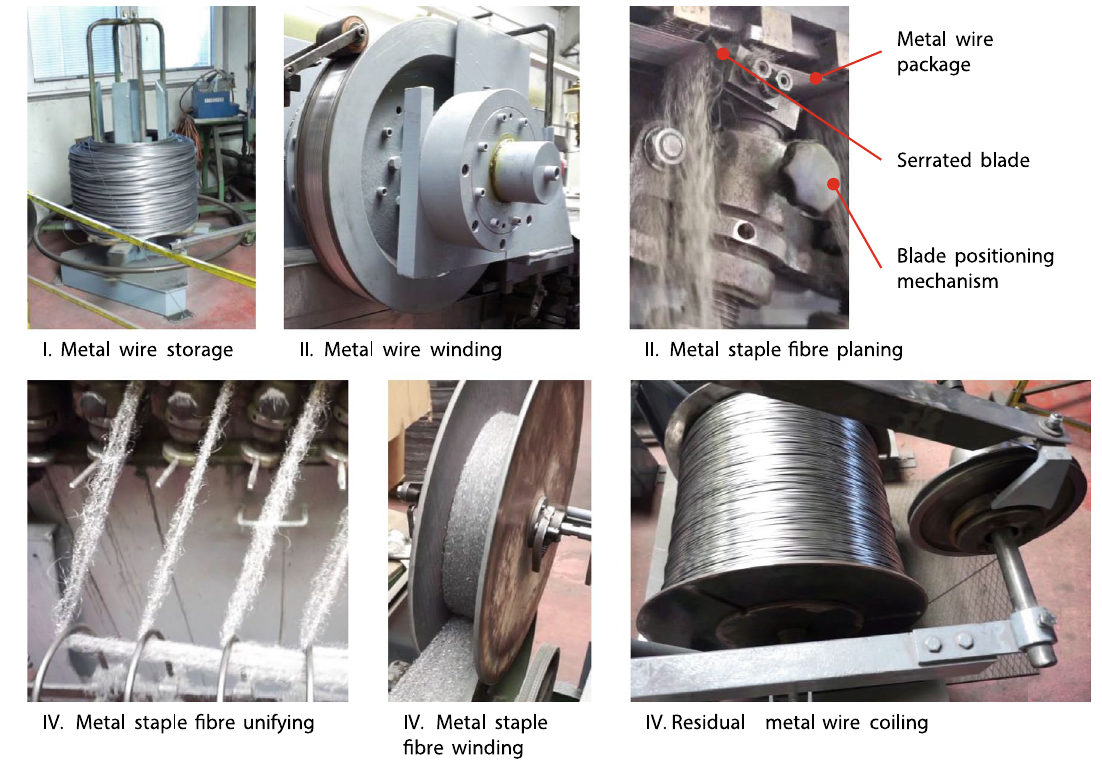
Fig. 2 Planing process for the production of metal staple